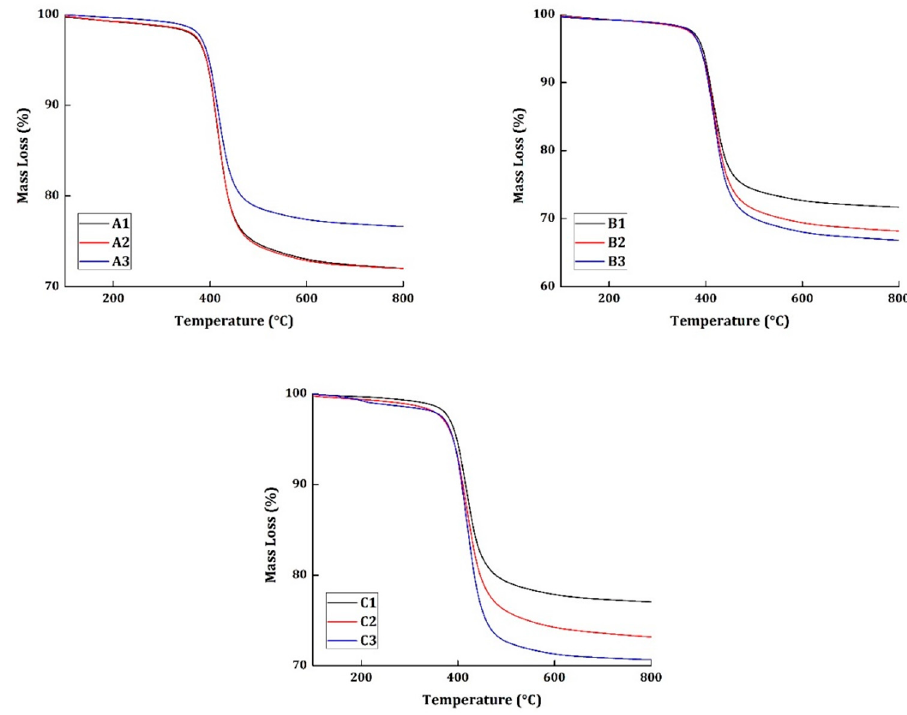
Figure 2. TG results of all the specimens tested at 20 °C/min heating rate.